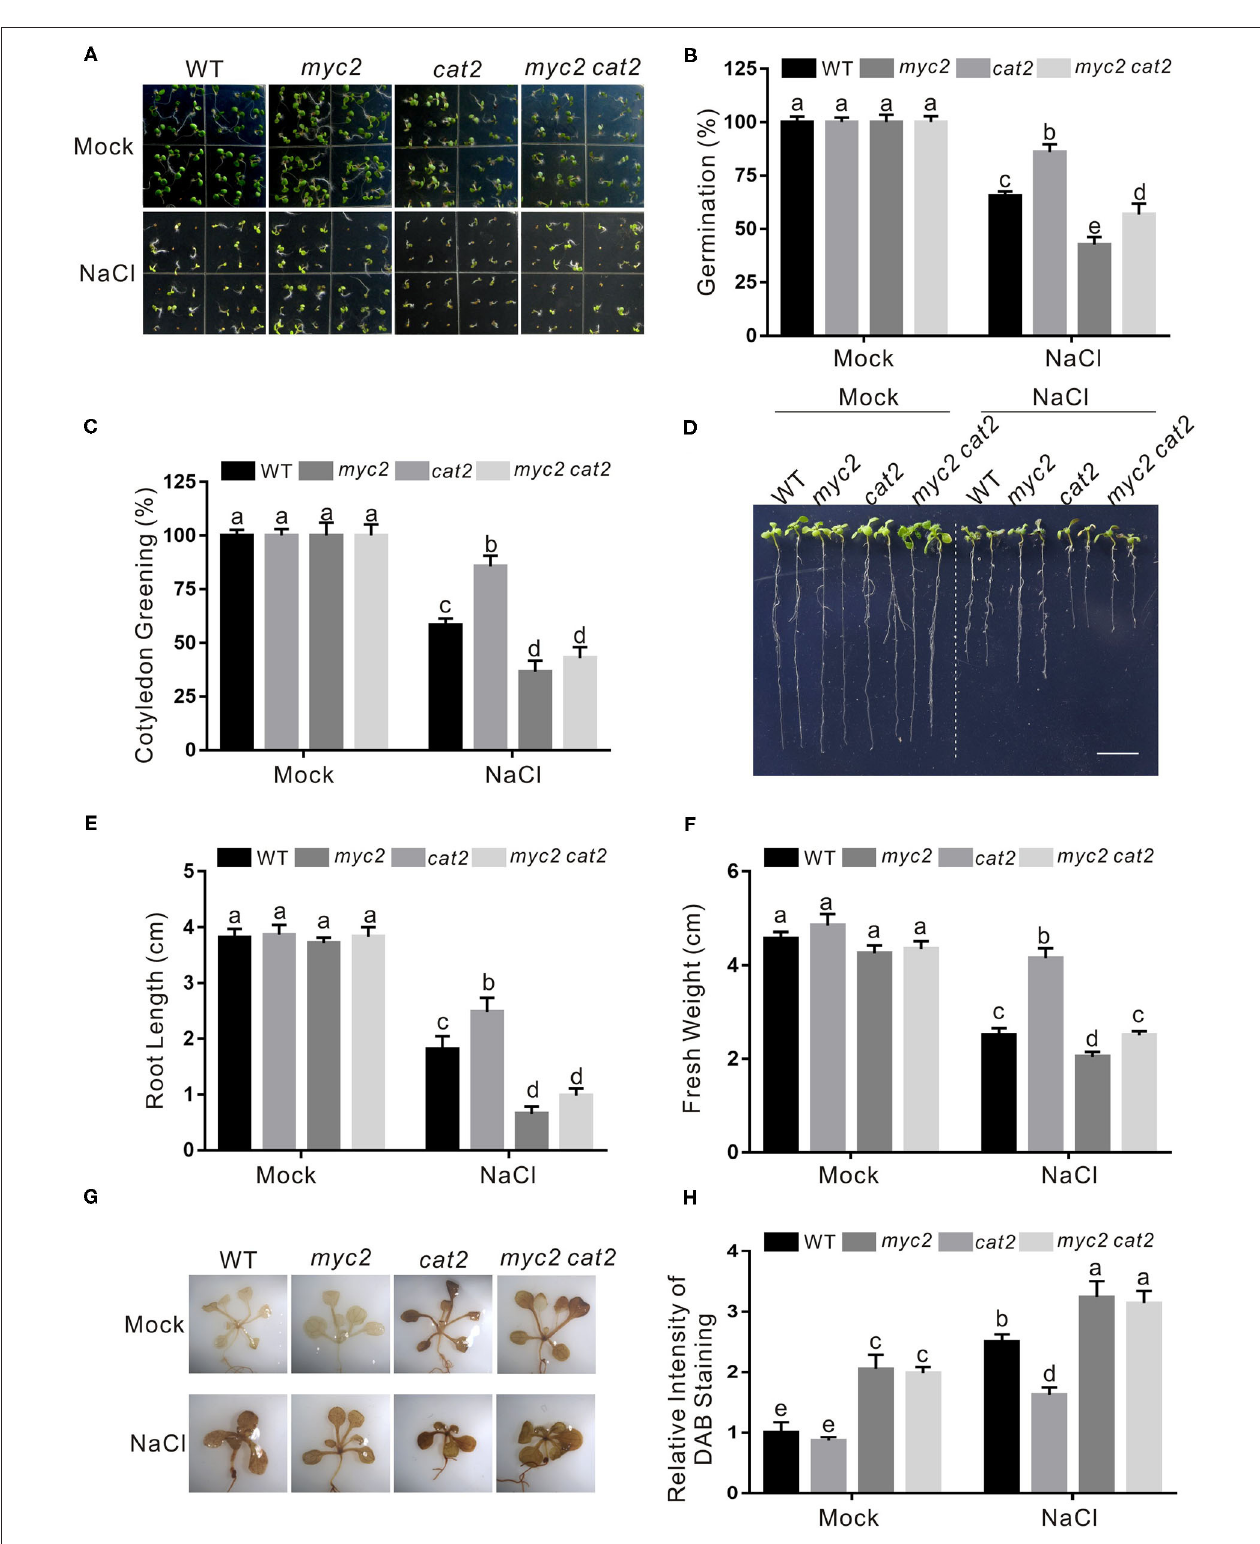
FIGURE 6 | CAT2 mutation reverts the insensitivity phenotype of myc2 to salt stress. (A) Images of 5-day-old wild-type, myc2 , cat2-1 , and myc2 cat2-1 mutant plants treated with or without 125mM NaCl. (B, C) Percentages of seed germination (B) and green cotyledons (C) of 5-day-old wild-type, myc2 , cat2-1 , and myc2